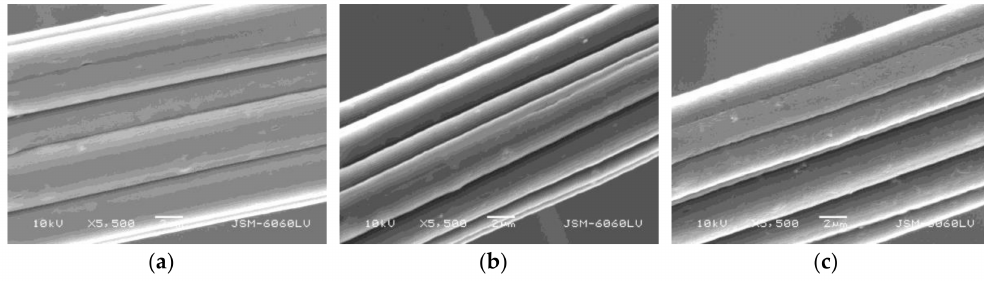
Figure 5. Surface of the regenerated cellulose fibers ( a ) Untreated; ( b ) Ultrasound treated and ( c ) Plasma treated; all at a magnification of 5500 × and a voltage of 10 kV.